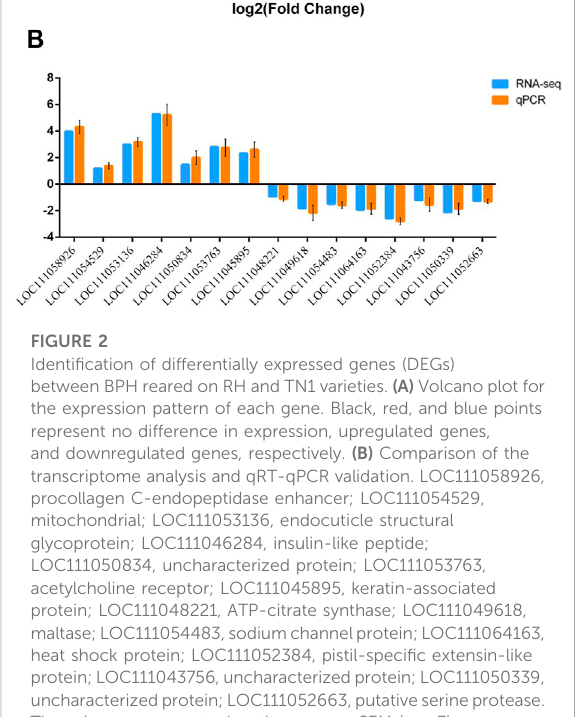
uncharacterizedprotein;LOC111052663,putativeserineprotease. The values are presented as the mean ± SEM ( n =